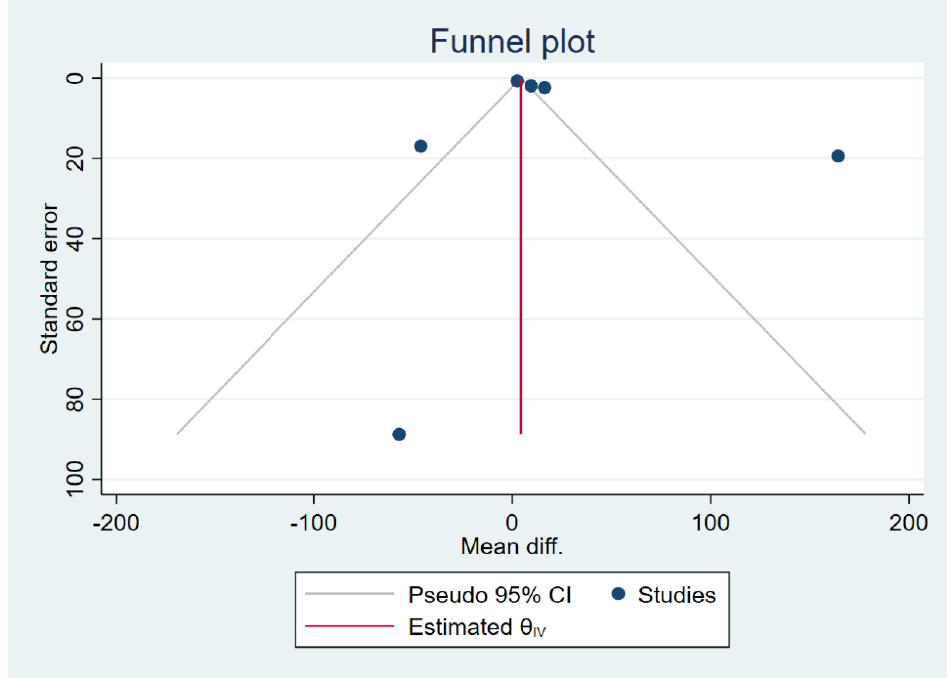
Figure 12. The funnel plot demonstrated the mean difference of IL-12 levels between uncomplicated malaria and healthy controls from each study. In addition, the funnel plots showed the asymmetrical distribution of the mean differences and the standard error (se) of the mean differences.